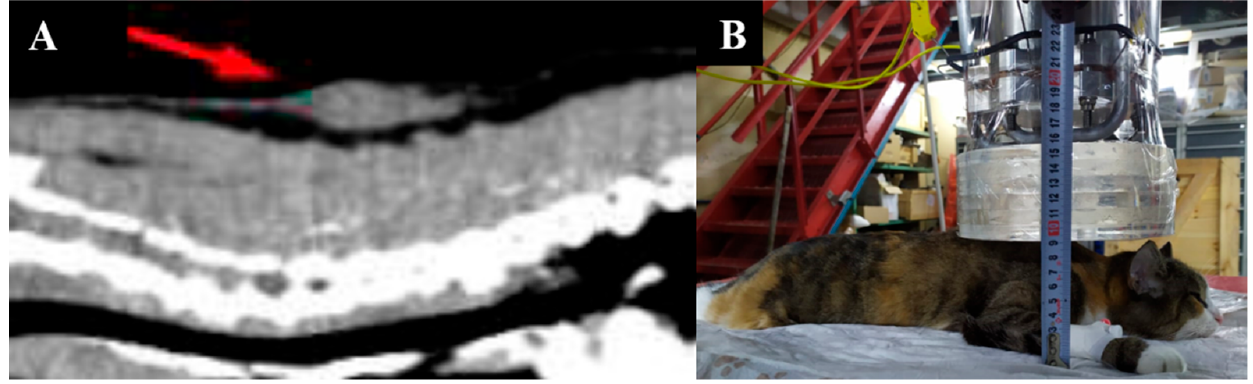
Figure 8. A cat named “Fenya”. ( A )—CT of soft tissues before irradiation. ( B )—positioning of the animal during the irradiation